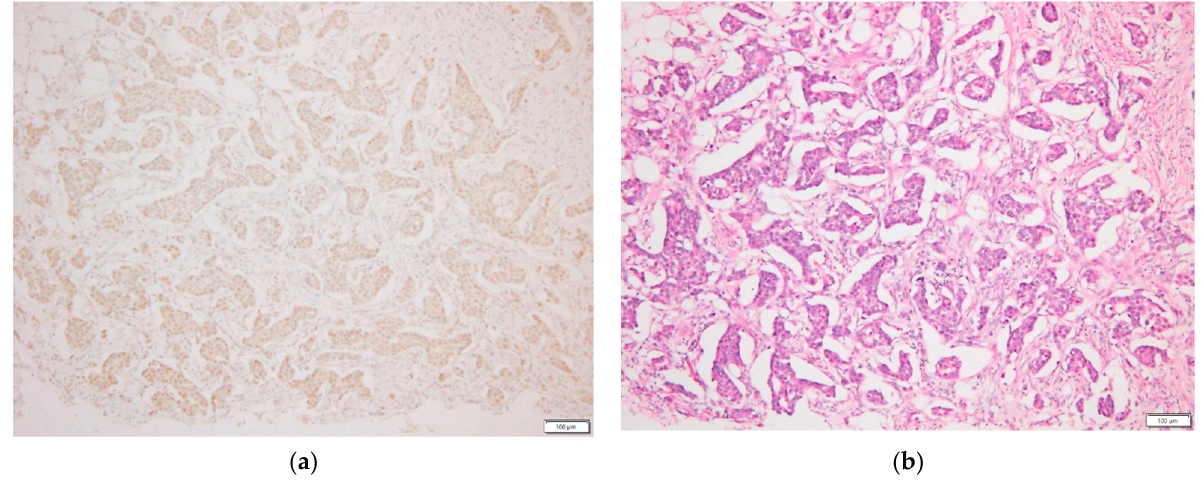
Figure 1. p-STAT3 positive example by immunostaining is shown. ( a ) This is a p-STAT3 positive case; ( b ) HE-stained image of the same case.